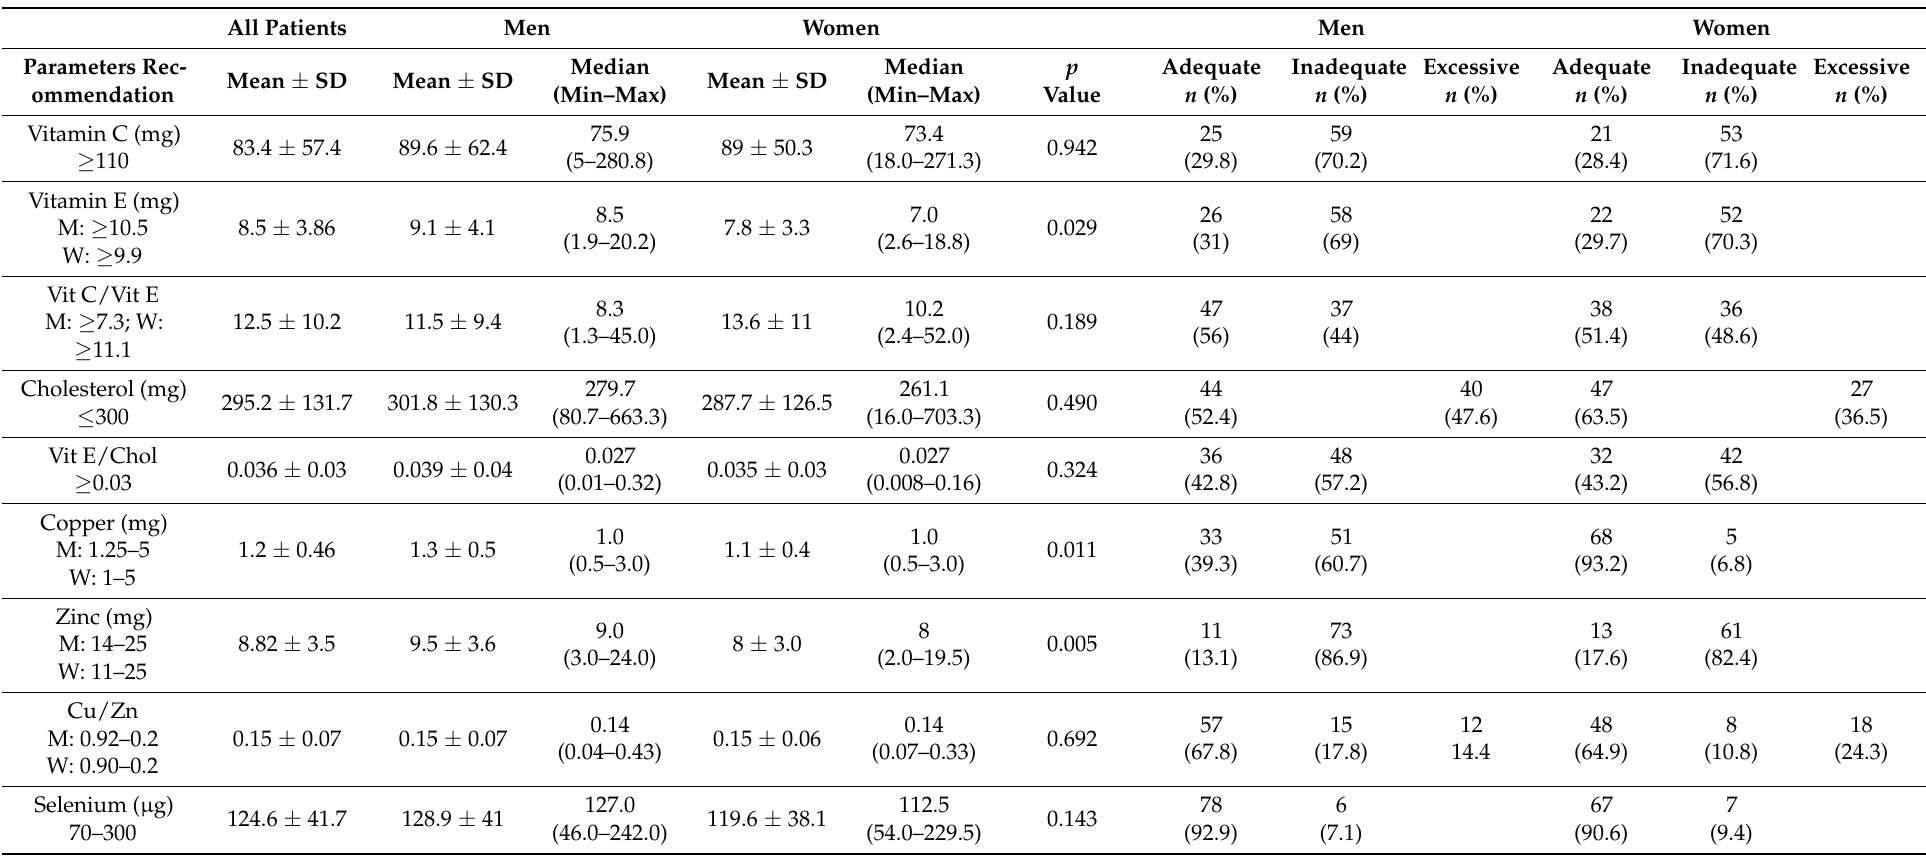
Table 7. Micronutrient and cholesterol intakes and their adequacy in 159 patients with FSHD. All Patients Men Women Men